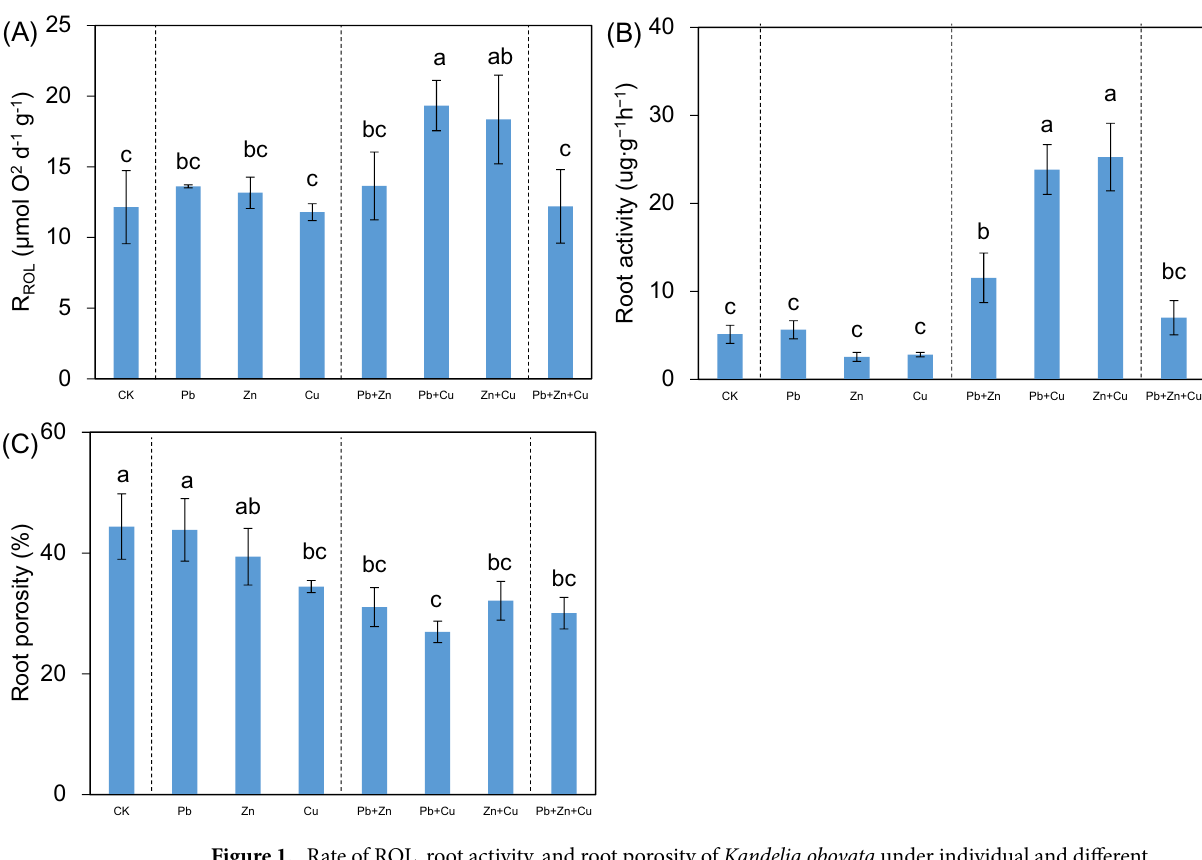
Figure 1. Rate of ROL, root activity, and root porosity of Kandelia obovata under individual and different combined stress of Pb, Zn, and Cu. Different lowercase letters indicate significant differences among treatments ( P <